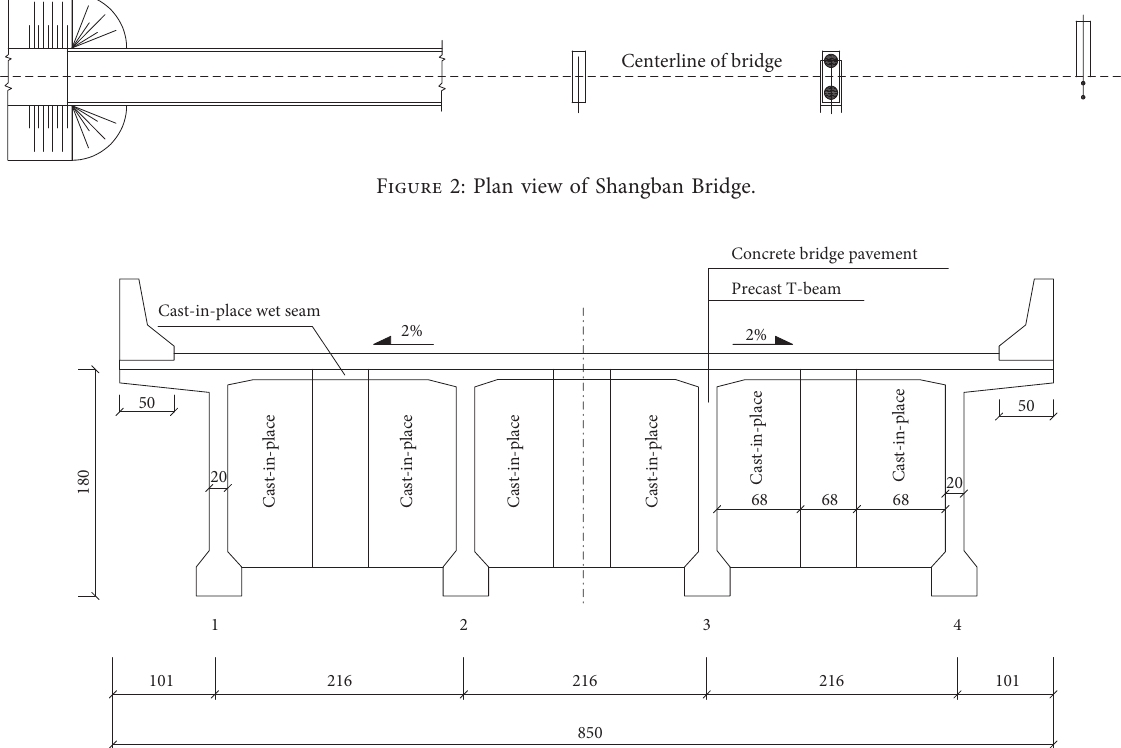
Figure 3: Cross-section of Shangban Bridge (dimensions in cm).